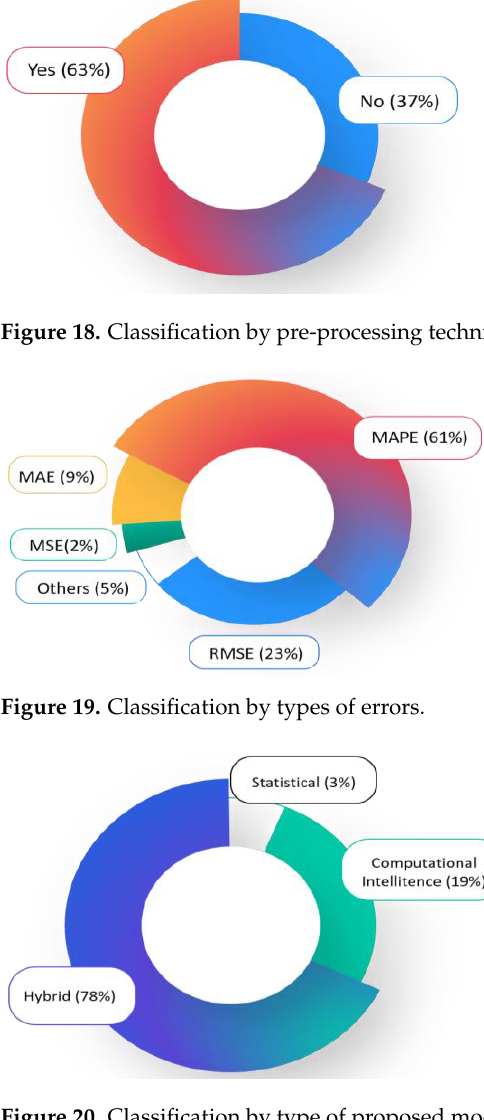
Figure 21. Classification by steps ahead. Figure 22. Classification by input data type. The need to generate a solid and reliable forecasting model is ongoing because the neural network models ’ accuracy depends on the training algorithm and its parameters, especially the data used for each forecast. So far, no neural network model outperforms others universally, but it is possible to know the accuracy offered by the different tech- niques based on valuation metrics. More than one neural network model is recommended when forecasting wind speed since it significantly affects forecasting accuracy. Pre-processing techniques such as WM can be used, in which a sequence of data is decomposed into several sub-series. WM is used to analyze signals by decomposition into several frequencies; under this concept, more methods are obtained with variations, improving the base model. Regarding post- processing, an option to achieve a more reliable result in forecasting accuracy than BMA is to provide a single model based on the prediction of wind speed with different neural network models, which provides a more reliable result. With the use of post-processing techniques, forecasting accuracy can be improved, and thus the integration of wind en- ergy into the power grid is benefited, which minimizes the risks due to forecasting errors.